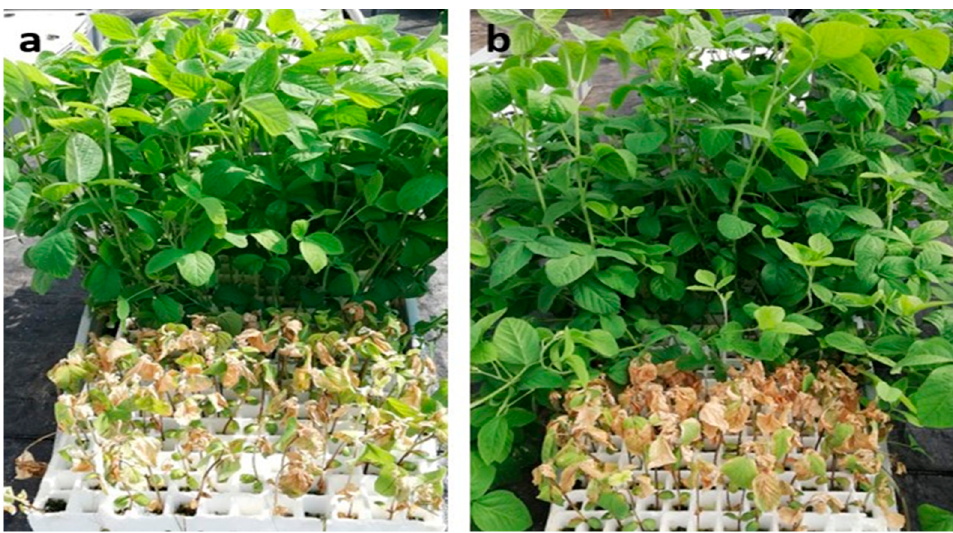
Figure 1. ( a ) 15 days after herbicide applied susceptible (dried plants in front) and resistant plant (no symptoms); ( b ) 30 days after herbicide applied susceptible (more dried) and resistant plant (still no symptoms)